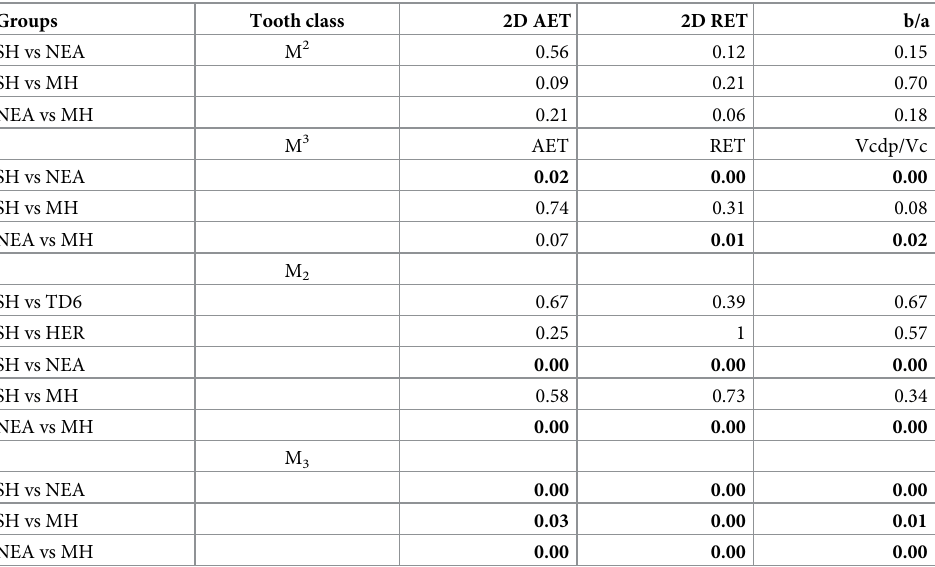
Table 3. Mann-Whitney comparative statistical test (significant p values (0.05) in bold) for the 2D measurements in SH, Neanderthals and modern humans. Groups Tooth class 2D